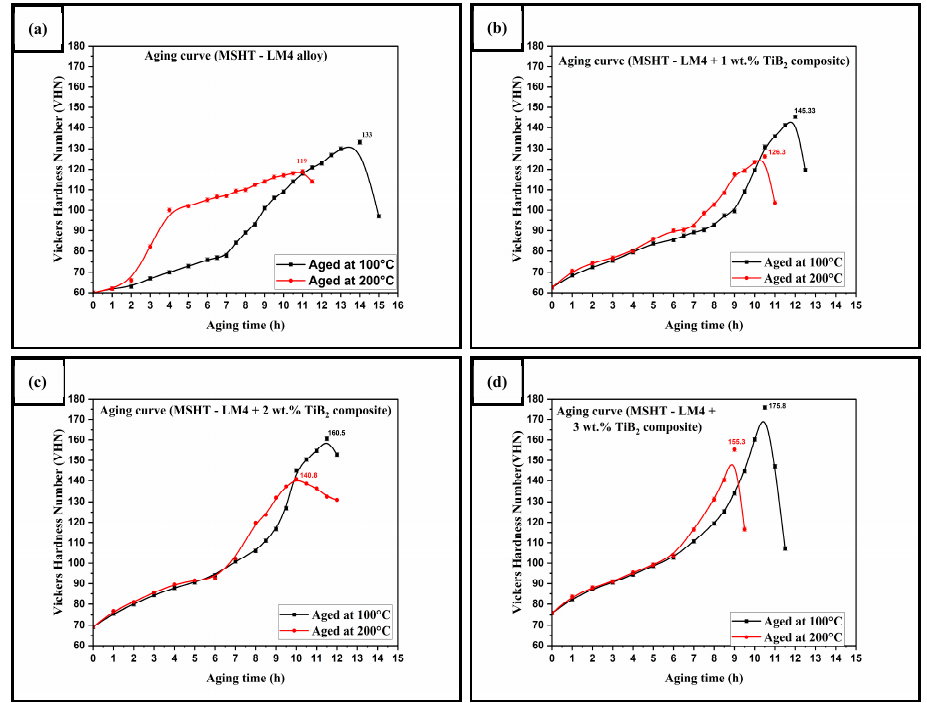
Figure 12. ( a – d ) Aging curves of the precipitation-hardened (MSHT + artificial aging) LM4 alloy and its